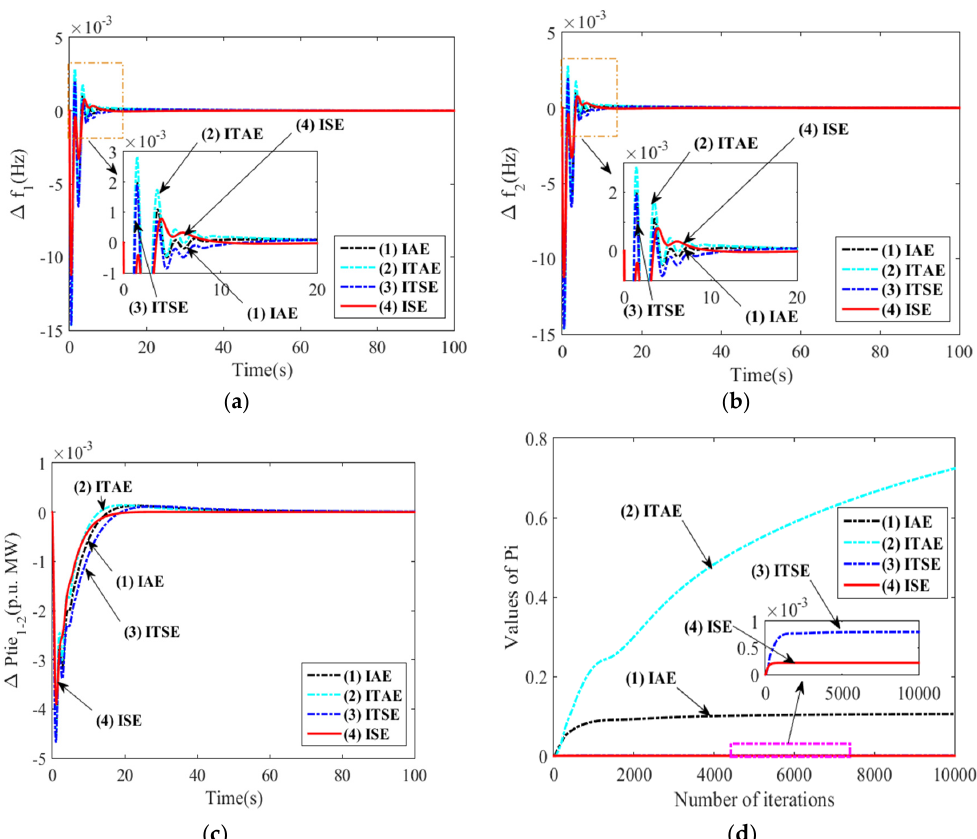
Figure 6. Evaluation for the recommendation of the Pi amongst IAE, ITAE, ITSE, and ISE for employing PDN(FOID) controller in the case of scheme-1 contrast time: ( a ) Anomaly of frequency of area-1, ( b ) Anomaly of frequency of area-2, ( c ) Anomaly of Tie-line power interlinking area-1 and area-2, ( d ) Convergence curve for the system with different Pi . Table 3. Peak anomaly and duration of settling for outcomes in Figure 6a–c in the case of scheme-1 employing SHO-optimized PDN(FOID) controller for diverse performance indices .